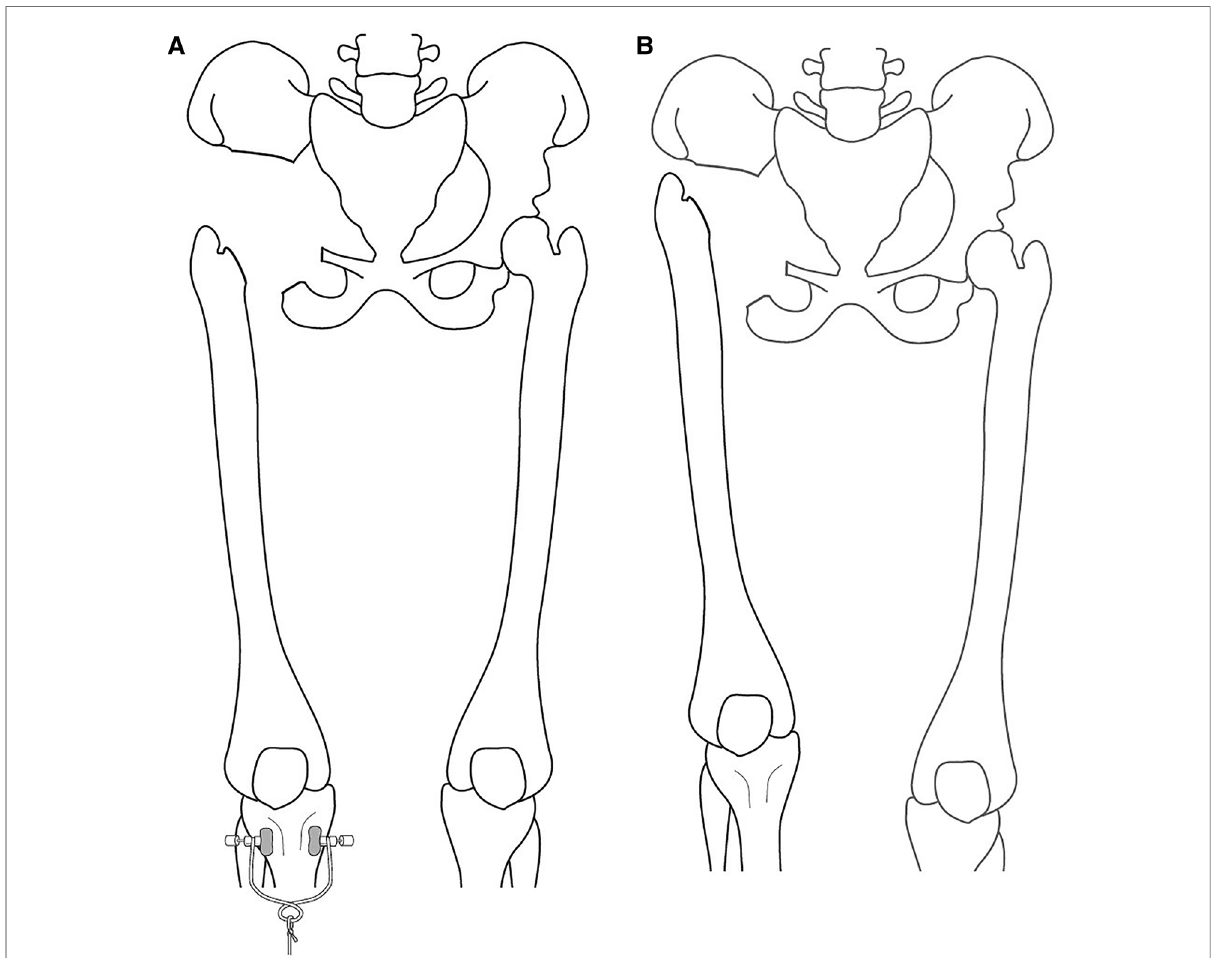
FIGURE 1 (A ) illustration of the surgical procedure under skeletal traction, showing the remaining bone defect following resection. ( B ) Illustration of the surgical procedure after the bony resection and traction removal. The traction allows the bone defect to be fi lled with reactive tissue, creating a mass effect to reduce the upward migration and decrease the LLD. *LLD - Leg length